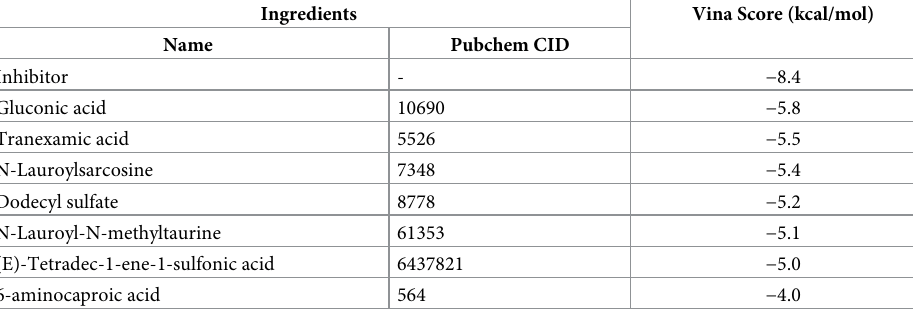
Table 4. Vina score of test ingredients for human TMPRSS2 model.